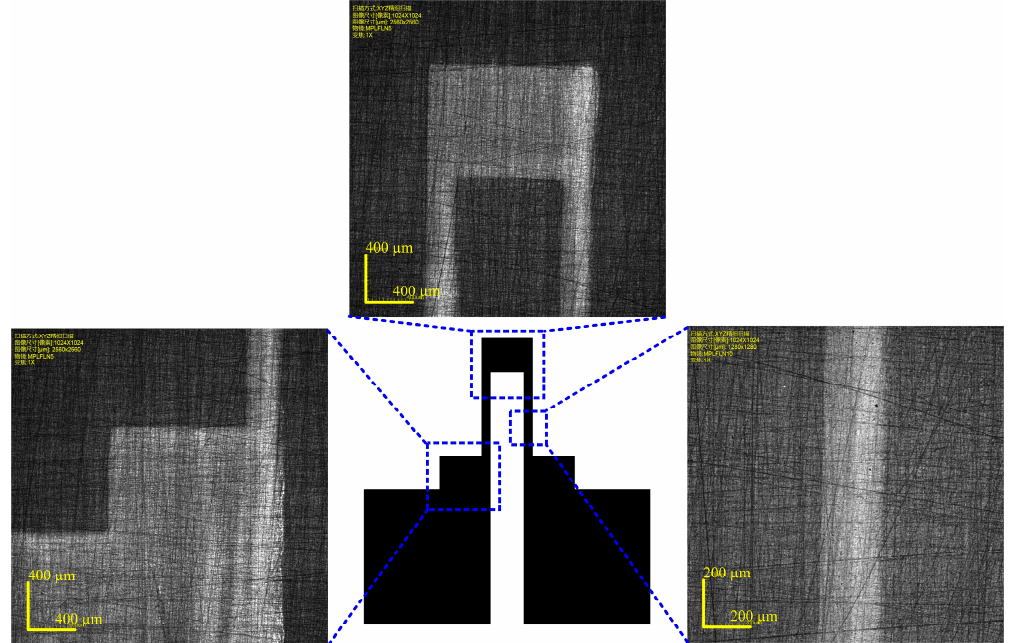
Figure 10. Confocal laser scanning microscope images of the strain gauge.